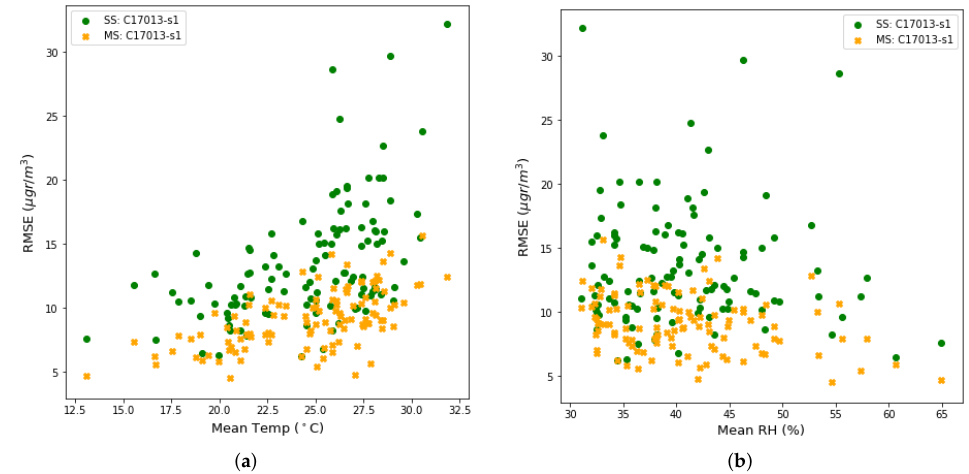
Figure 13. ( a ) Test RMSE versus average temperature in a per day basis, ( b ) Test RMSE versus average Relative Humidity in a per day basis. In green the single-scale case and in orange the multi-scale case. The green dots represent the s 1 sensor of the Captor 17013 node placed in the Manlleu